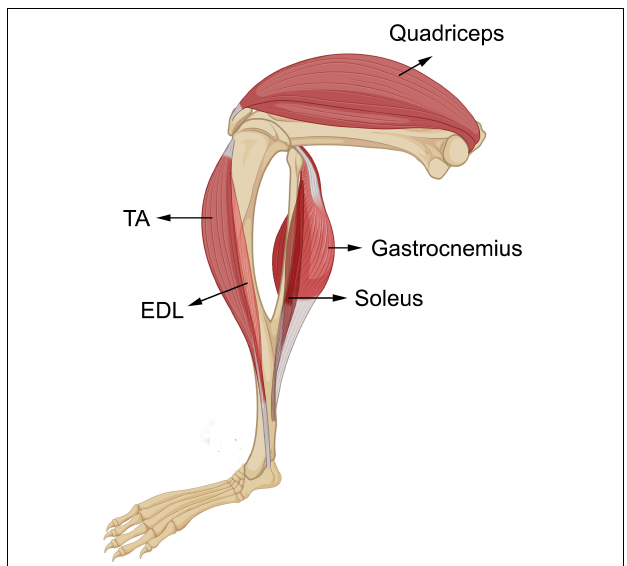
FIGURE 2 | Skeletal muscles of the hindlimbs of wild-type male mice. Five skeletal muscles from the hindlimbs of wild-type mice, ELD, soleus, TA, gastrocnemius, and quadriceps were collected in this study. EDL and soleus are the two smallest skeletal muscles under investigation, TA is a medium-sized skeletal muscle, and gastrocnemius and quadriceps are the two heaviest tissues. EDL and TA are located on the front of the hindlimb underneath the knee. Soleus and gastrocnemius are located on the back lower part of the hindlimb. Their tendons are in the Achilles’s tendon. Quadriceps is one of the biggest skeletal muscles of the organism and resides on the front of the upper part of the hindlimb.